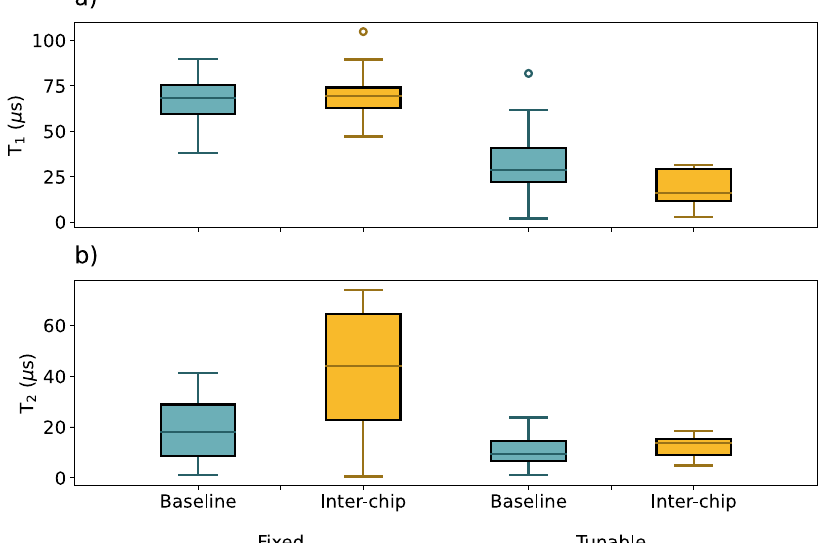
Fig. 7 Comparison of T 1 and T 2 for qubits with inter-chip coupling (inter-chip) compared to qubits on devices from similar wafers without inter-chipcouplers (baseline). The baseline data includes 4 fi xed qubits and 27 tunable qubits while the inter-chip data includes 12 fi xed and 12 tunable qubits, and for each qubit the measured values are averaged over several measurements taken over the course of a week. The boxes plotted depict the four inter-quartile ranges for the distribution of average values with outliers shown as hollow circles. Tunable qubits have lower T 1 and T 2 due to the coupling of the fl ux bias line to the qubit and are thus plotted separately here.